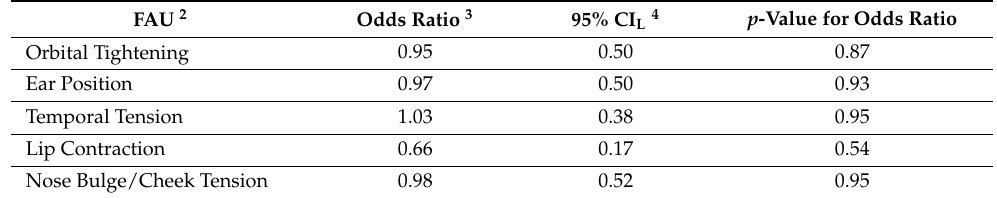
Table 1. Likelihood of castrated piglets scoring in a higher grimace category compared to sham- castrated piglets 1